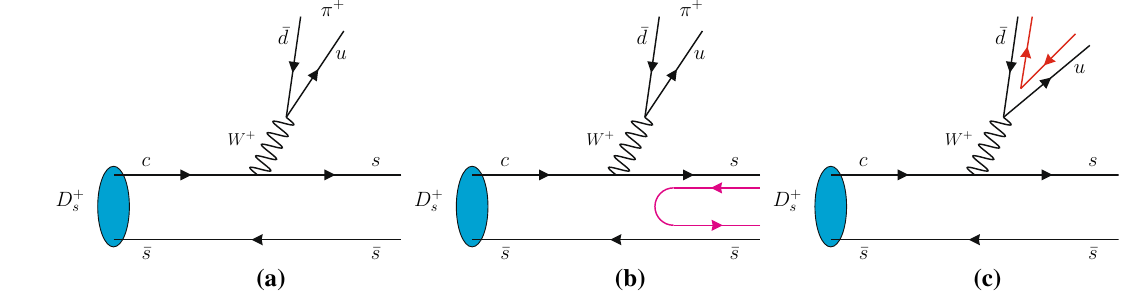
Fig. 1 Cabibbo-favored decay mode of D + s at the quark level with external emission ( a ); Hadronization of the s ¯ s component ( b ); hadronization of the ¯ du component ( c